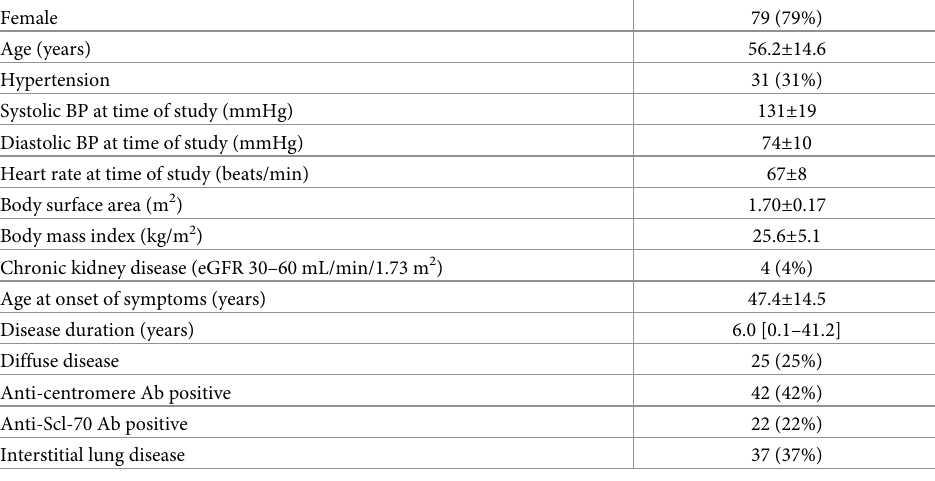
Table 1. Clinical characteristics of subjects with systemic sclerosis (n =